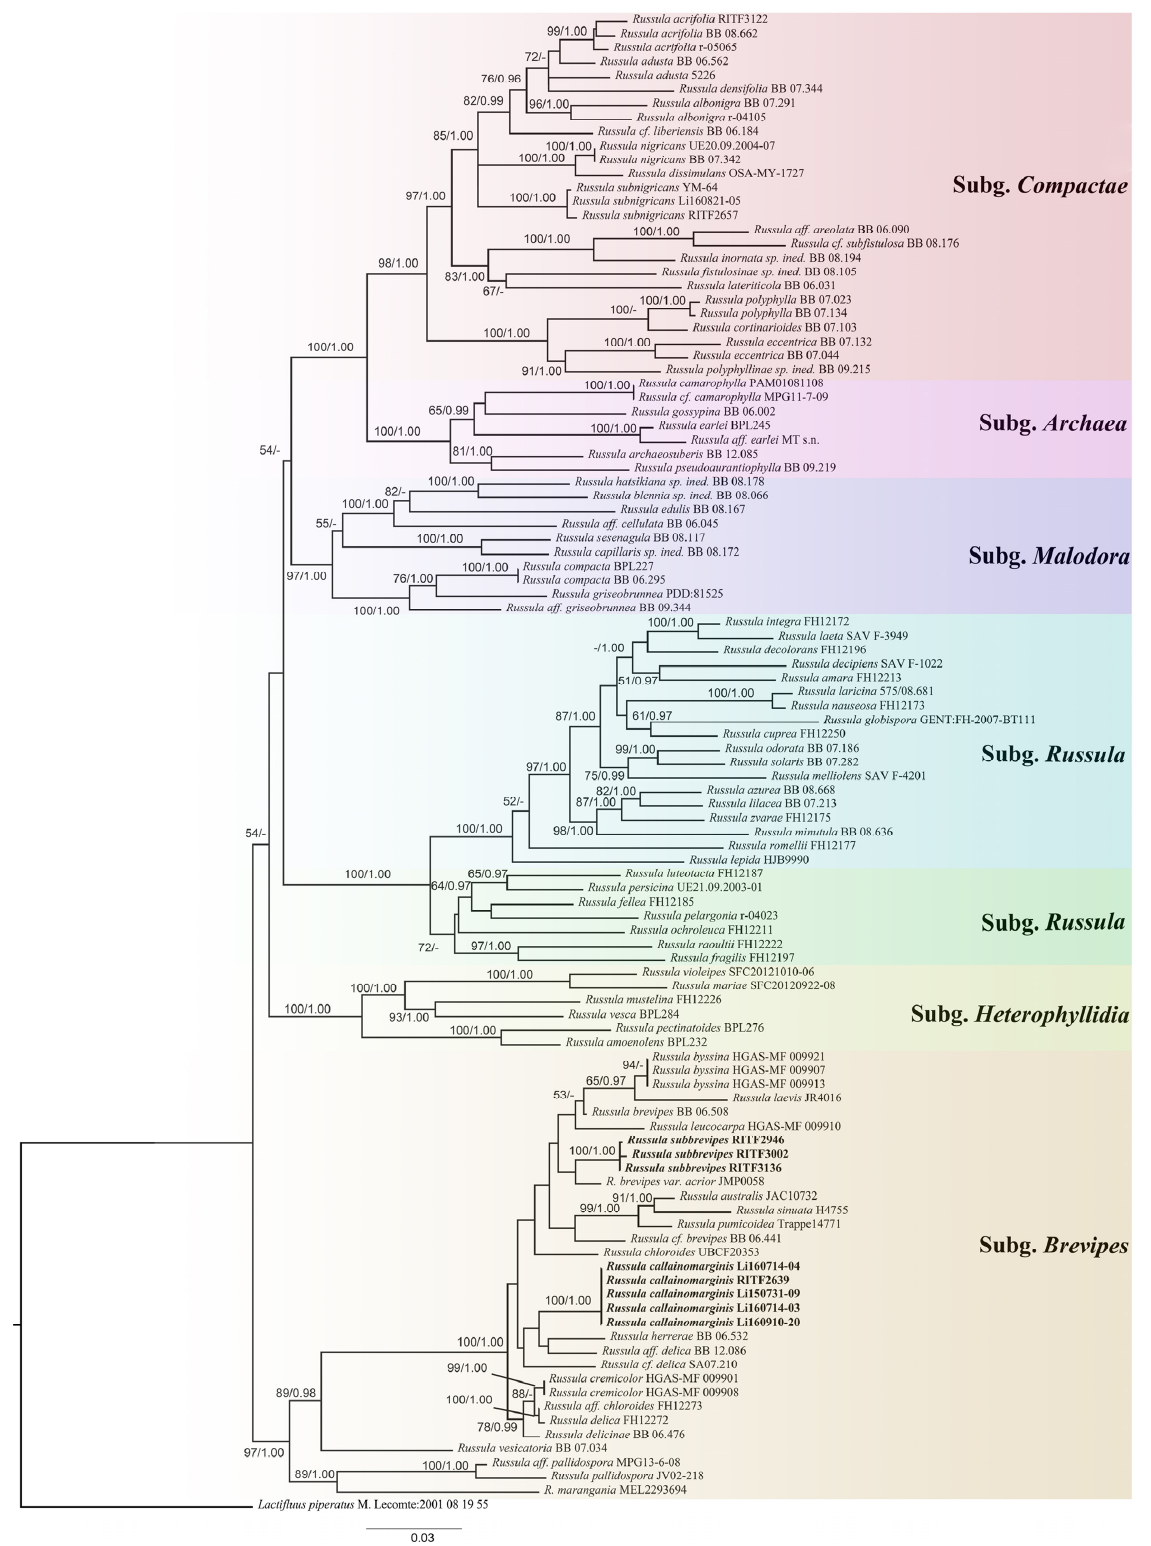
Figure 1. Phylogenetic consensus tree inferred from the maximum likelihood (ML) analysis based on ITS+nrLSU+mtSSU+ RPB2 sequence data. Branches are labelled with maximum-likelihood bootstrap proportions (BS) higher than 50% and Bayesian posterior probabilities (BPP) more than 0.95: bold names = new